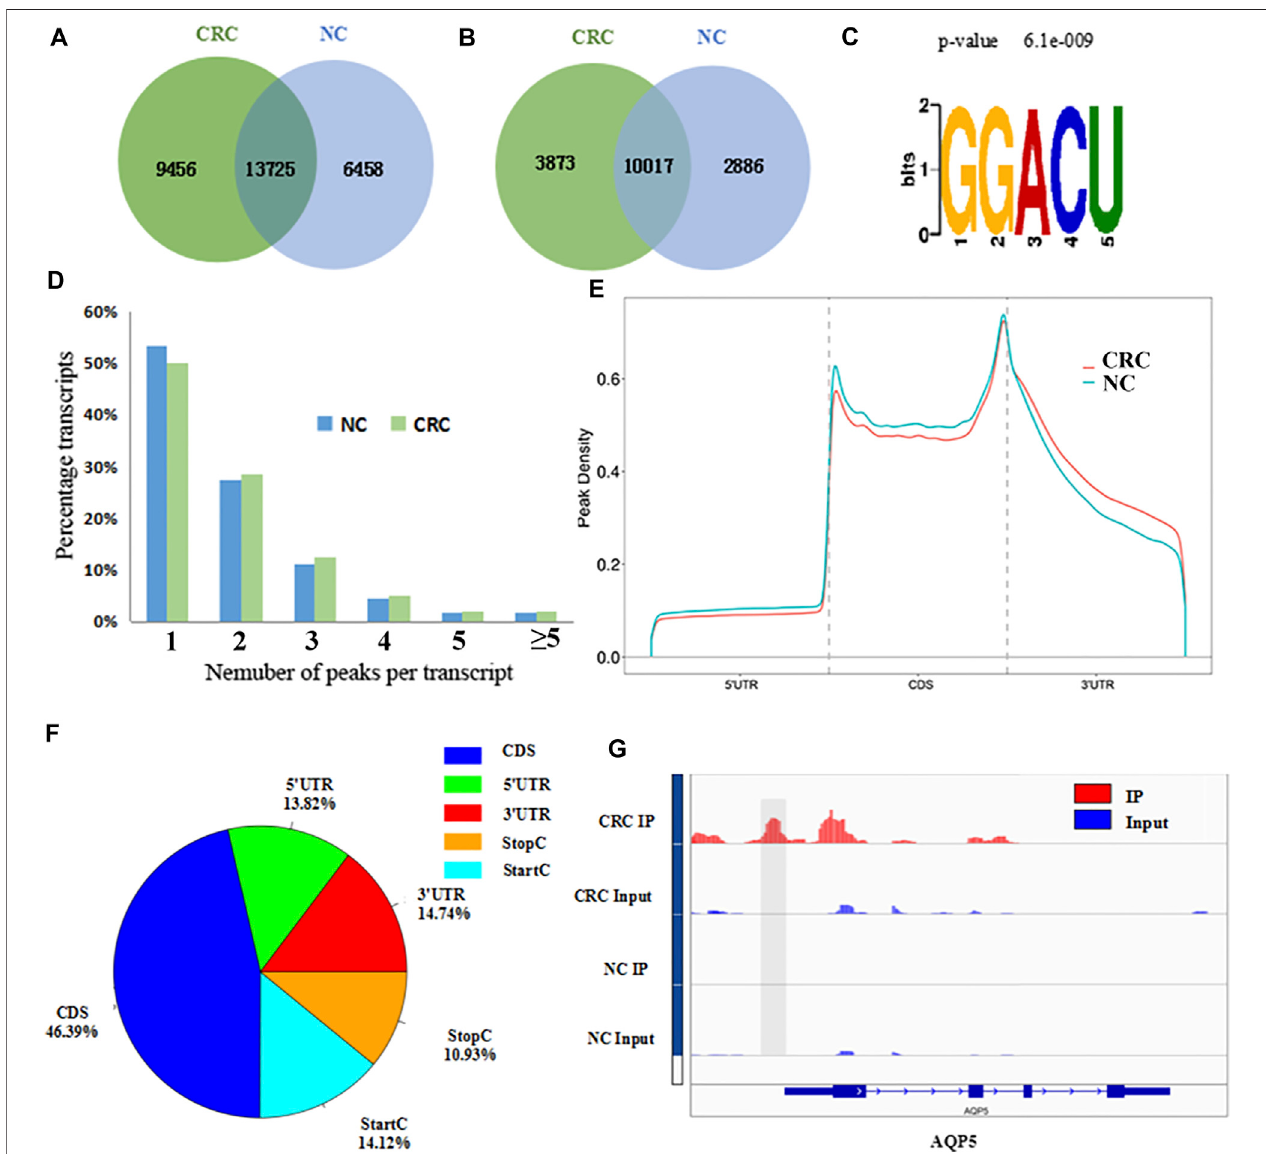
FIGURE1| Overviewofm 6 AmethylationpatternsinCRCtissuesandNCtissues. (A) VenndiagramindicatingtheintersectionofmRNAm 6 ApeaksinCRCtissues and NC tissues.(CRC: colorectal cancer; NC:normal control). (B) The number ofm 6 Apeak-represented transcriptsinCRC tissuesand NC tissues. (C) Sequence motif ofm 6 Apeak regions. (D) Theproportionsoftranscriptswithdifferentnumberofm 6 Apeaks inCRC tissuesand NCtissues. (E) Distribution ofm 6 Apeaksidenti fi edinthe entiretranscriptomeinCRCandNC. (F) Thepercentageofm 6 Apeaksin fi venon-overlappingsegments. (G) DatavisualizationofAQP5mRNAm 6 Amodi fi cationin CRC tissues and NC